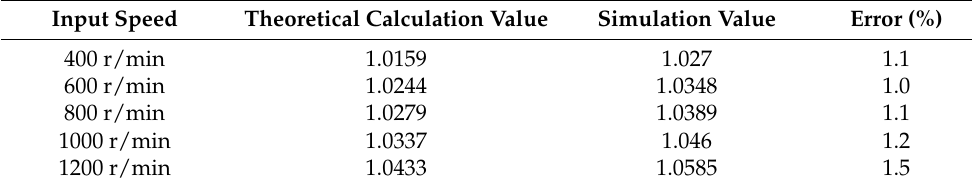
Table 4. Average value comparison of load proportional coefficient under different input speeds.